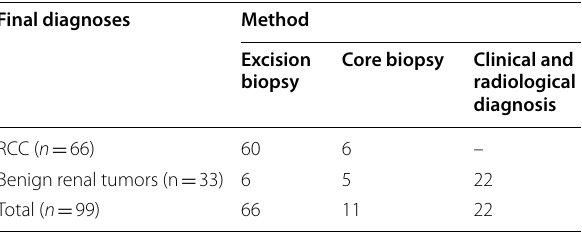
Table 2 Final diagnosis of the lesions and the method of diagnosis